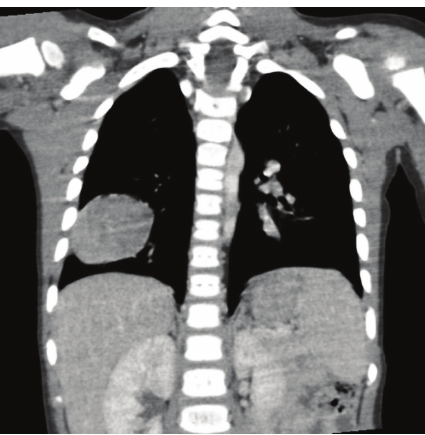
Figure 1: CT chest: right lung lower lobe peripheral mass.